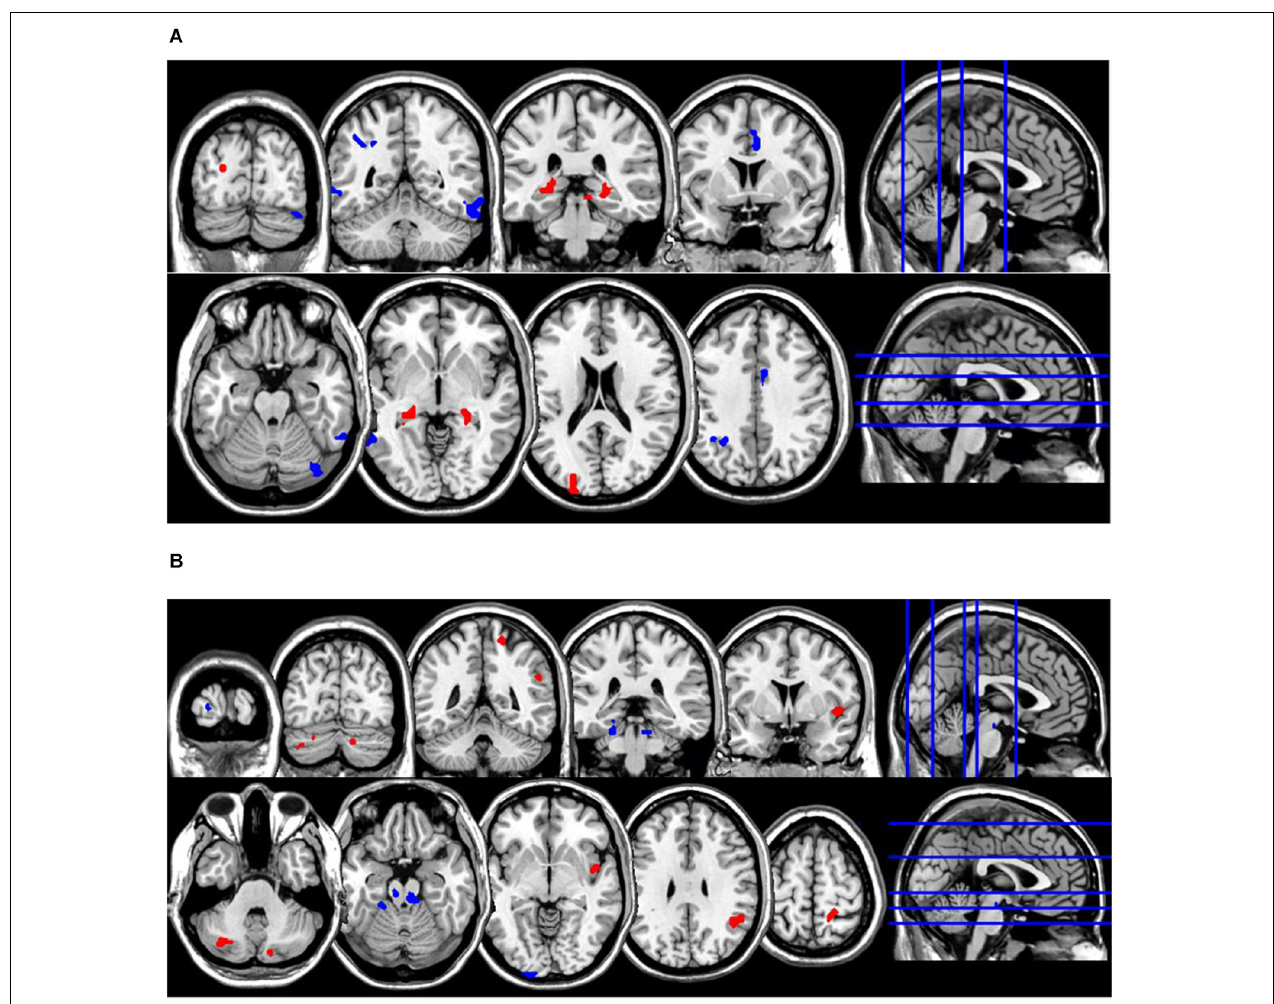
FIGURE 4 | Coronal and axial multislice views of regions showing correlations between ReHo values in the NM group and estimates of (A) retrospective disturbed dreaming frequency and (B) prospective disturbed dreaming frequency. Color code; red, regions for which the retrospective disturbed dreaming frequency estimates were associated with increased ReHo values; blue, regions for which the retrospective disturbed dreaming frequency estimates were associated with decreased ReHo values. Significant regions were obtained with the following combination of statistical thresholds: p < 0.01 at voxel level within clusters >